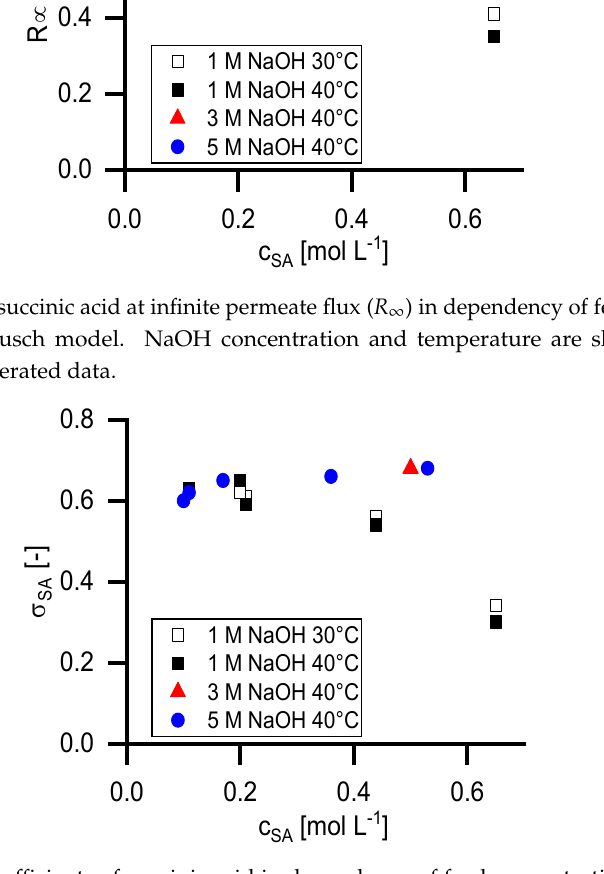
Figure 7. Reflection coefficients of the sodium ions in dependency of succinic acid feed concentration. The dots represent calculated values with the Spiegler and Kedem model, based on experimental data. Crosses represent the calculated reflection coefficients according to Equation (8). 4.6. Retention of Disodium Succinate